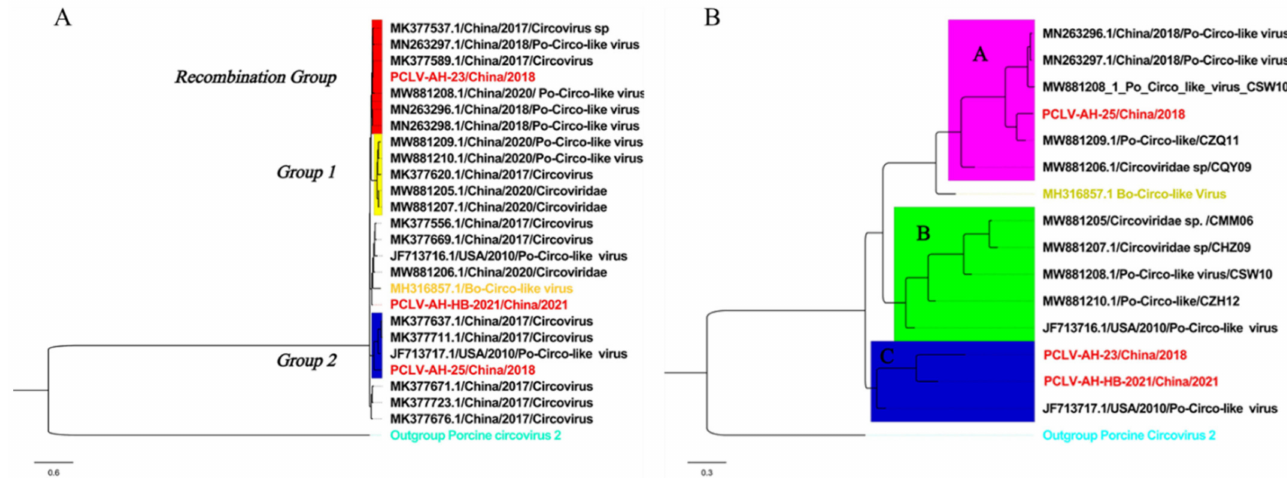
Figure 4. Phylogenetic analysis based on complete sequences and Rep . Strains from this study are marked in red. ( A ) Rep : The best substitution model was TIM2 + F + G4. Branches marked in yellow are those with recombination events, and Mutation Groups 1 and 2 are strains with mutations. ( B ) Complete sequences: The best substitution model was TPM3 + F + G4. The tree is divided into three branches, each underlined with a different color.